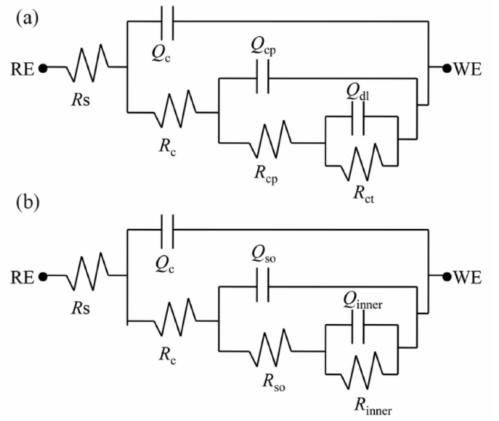
Figure 11. Equivalent circuit models of the CaPh-coated samples: ( a ) 5 min to 120 h f for HT-C and AT-C samples; ( b ) 5 min to 120 h for PEO-C